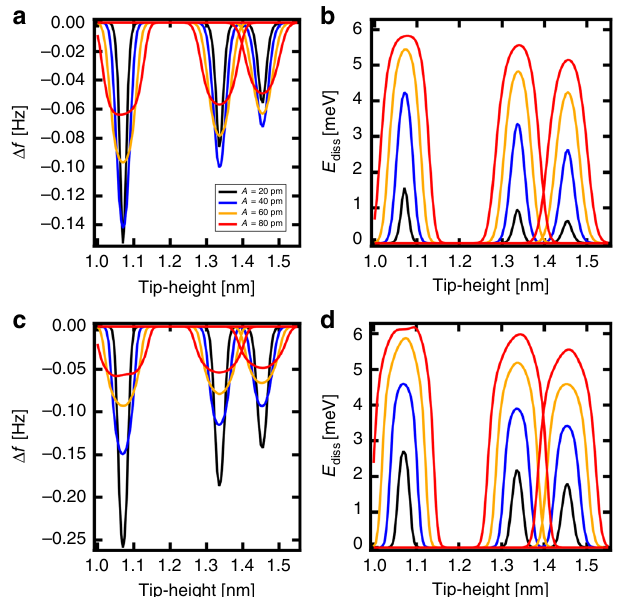
Fig. 5 Dependence of the simulated frequency shift and dissipation signal on the oscillation amplitude. a The frequency shift and ( b ) the dissipated energy obtained with the full model with both the Marcus and explicit DOF for different tip-heights and different tip amplitudes ( A = 20, 40, 60 and 80 pm); ( c ) the frequency shift and ( d ) the dissipated energy obtained with the all-Marcus model (without the explicit DOF) for different tip-heights and different tip amplitudes ( A = 20, 40, 60, and 80 pm). The simulations are performed for 5